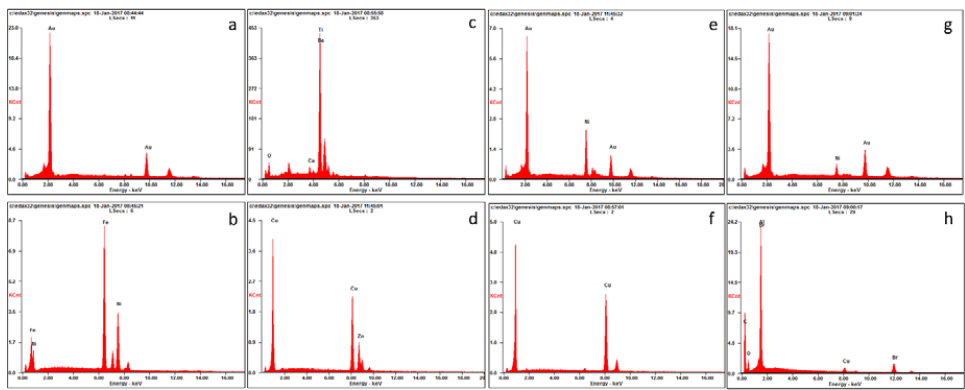
Figure 4. Electron Dispersive Spectroscopy (EDS) spectra corresponding to Figure 3 (The label of spectra is corresponding to the label of compounds in Figure 3A–C).